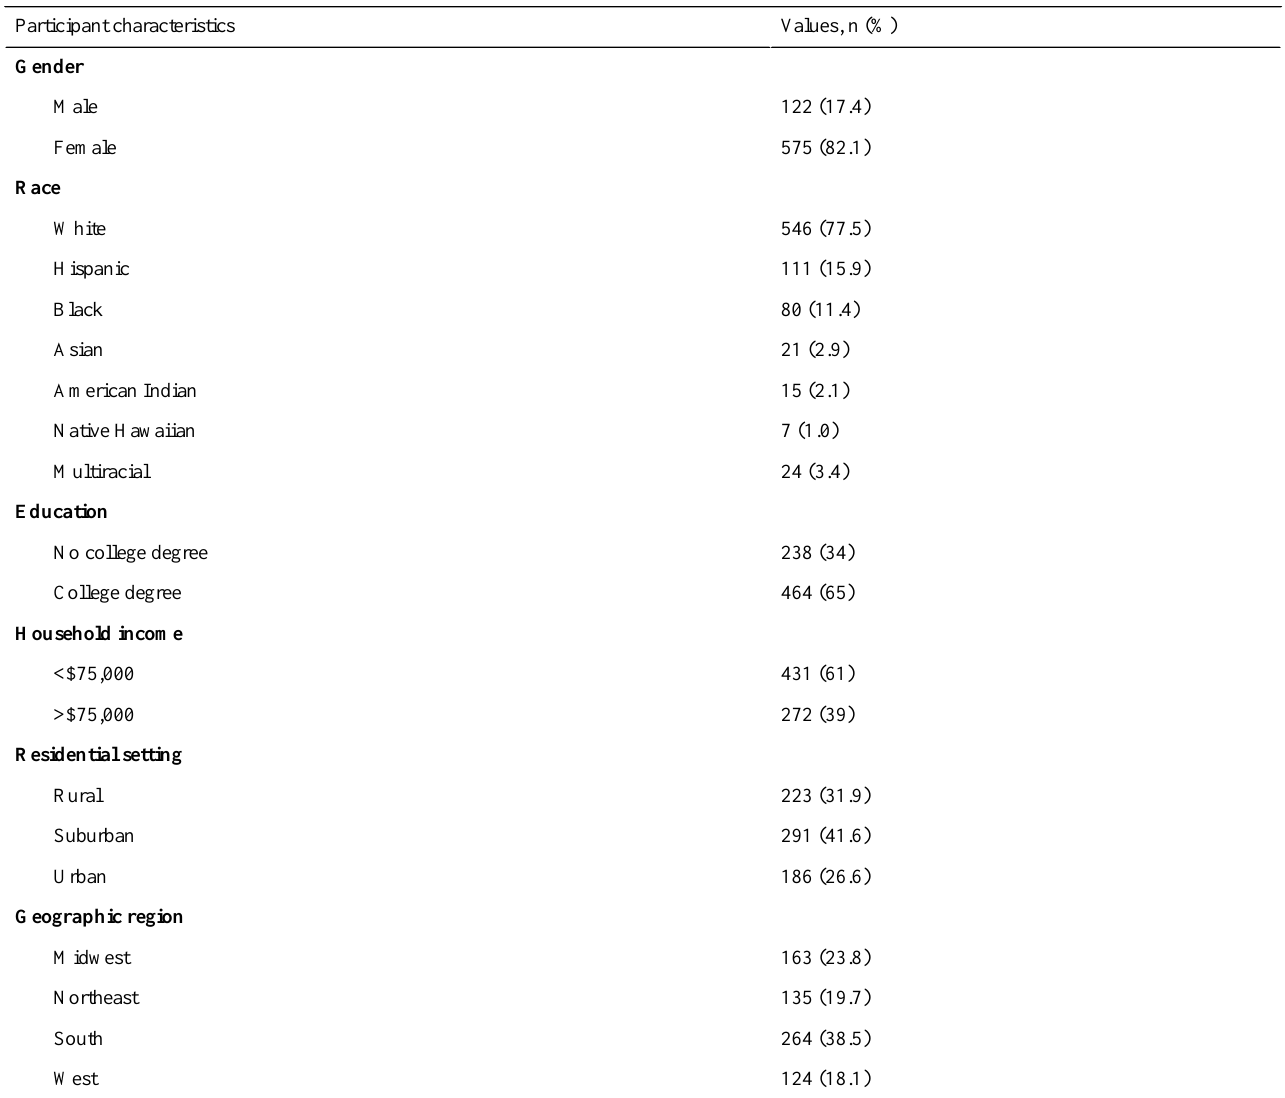
Table 1. Demographic data of the parent participants